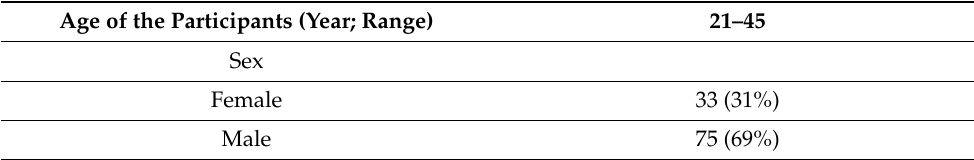
Table 1. Demographic characteristics of the study subjects ( N = 108). Age of the Participants (Year;